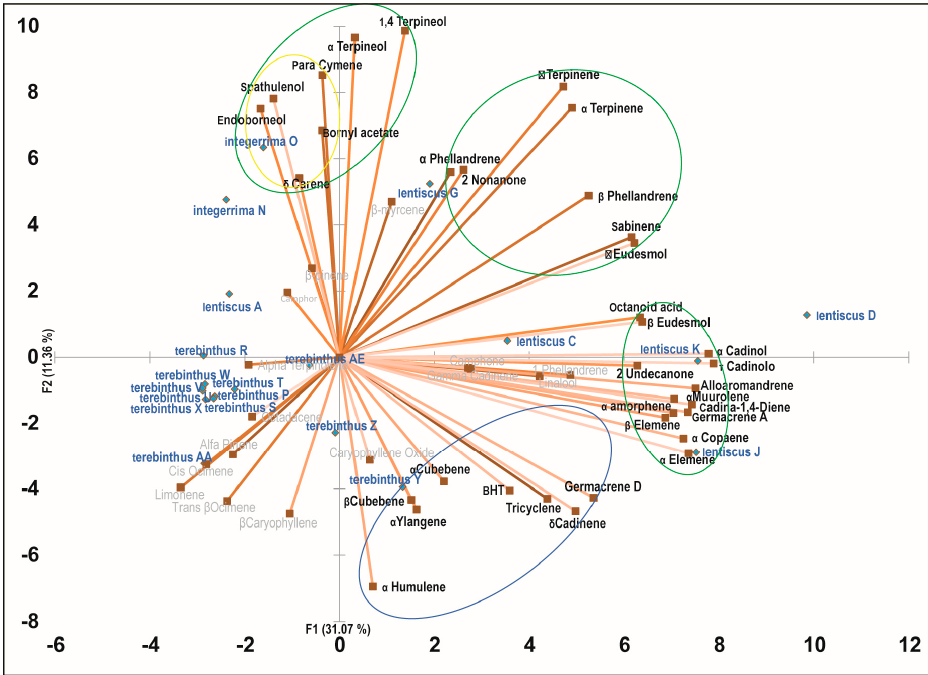
Figure 2. Principal component analysis of the cytotoxic effect of Pistacia essential oils on 2008 cells. PCA biplot with PC1 and PC2 distribution of essential oil samples and chemical components of the phytocomplexes. Clusters of cooperating compounds with a positive correlation to one or two components are identified with circles (green for P. lentiscus , yellow for P. integerrima , and blue for P. terebinthus ).